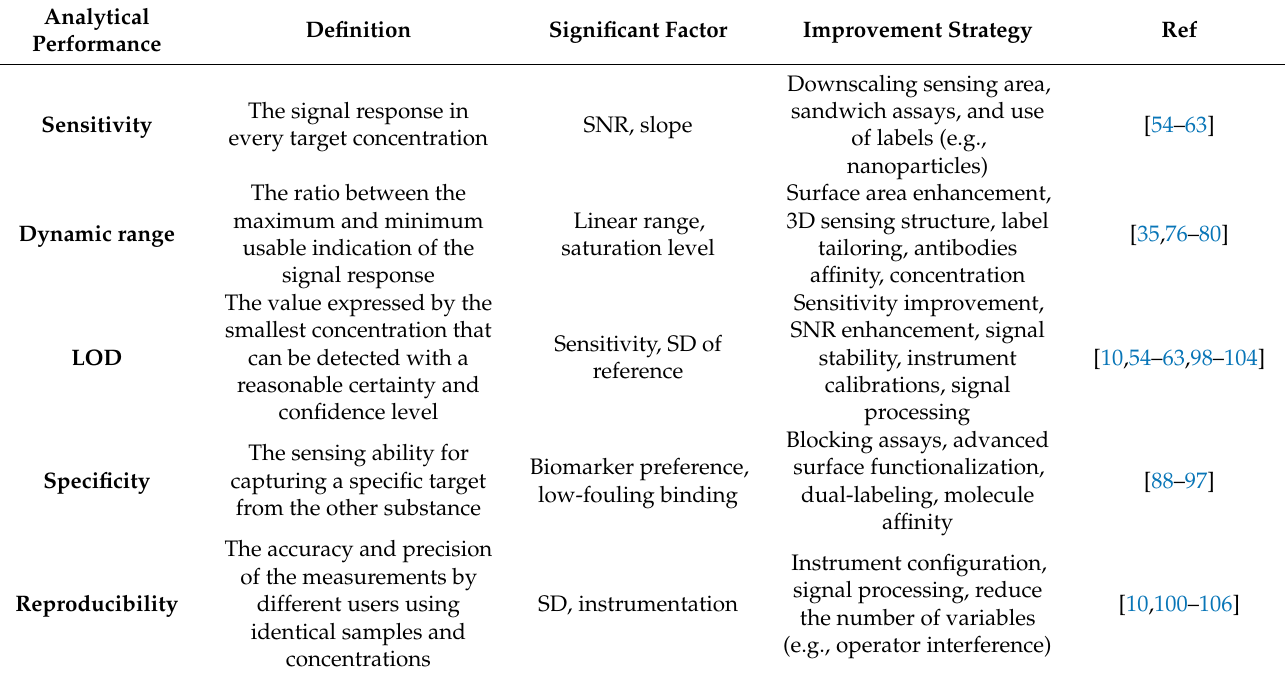
Table 4. Analytical performance of a